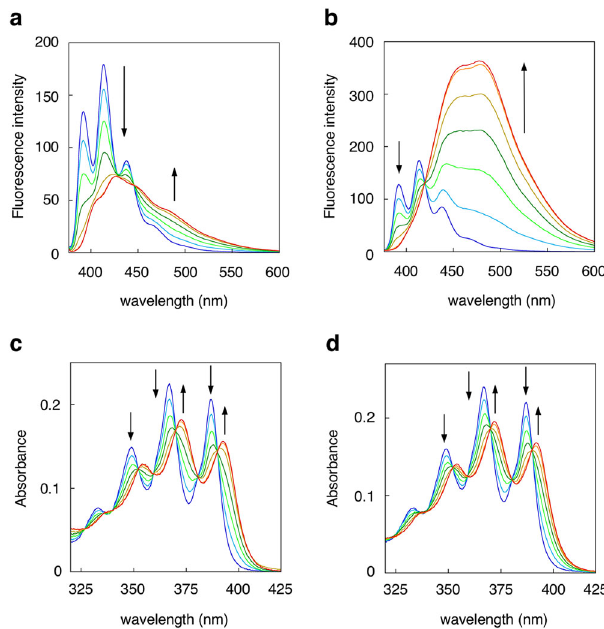
Fig. 2 Fluorescence and absorption response of probe 5 toward metal ion. Fluorescence and absorption spectral changes of probe 5 upon the addition of ZnCl 2 ( a , c ) or CdCl 2 ( b , d ). Measurement conditions: [ 5 ] = 25 μ M, [ZnCl 2 or CdCl 2 ] = 0 − 30 μ M, 50 mM HEPES (pH 7.4)/MeOH = 1:1, λ ex = 365 nm, 25